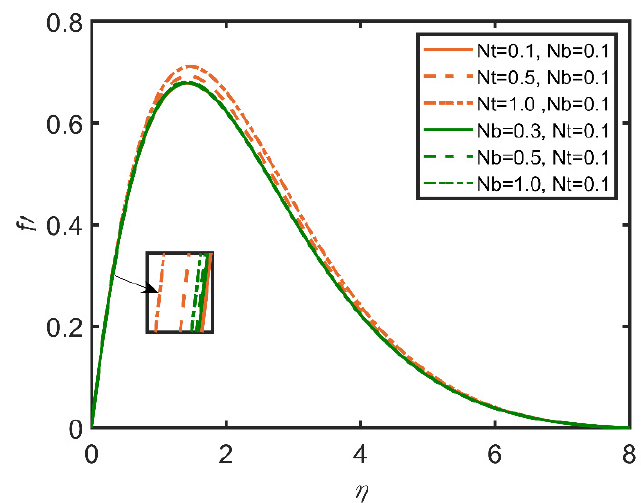
Figure 7. Comparison for velocity profile against 𝜂 .